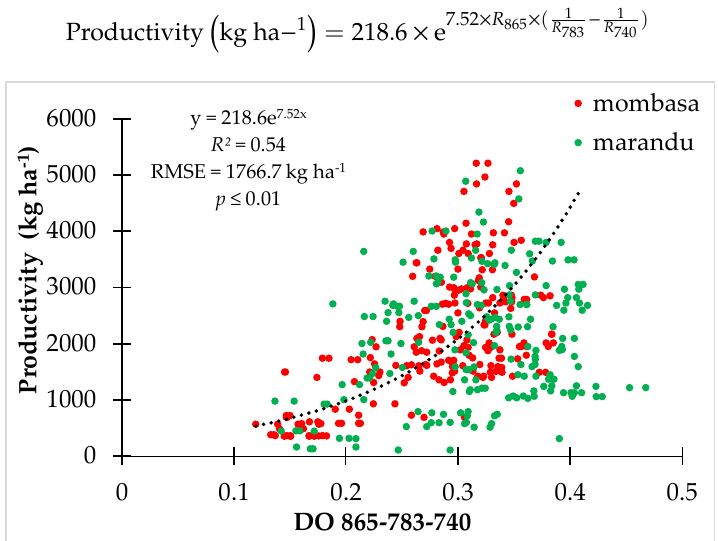
Figure 14. Biomass productivity as a function of the DO vegetation index in the Marandu and Mombasa experimental study area.